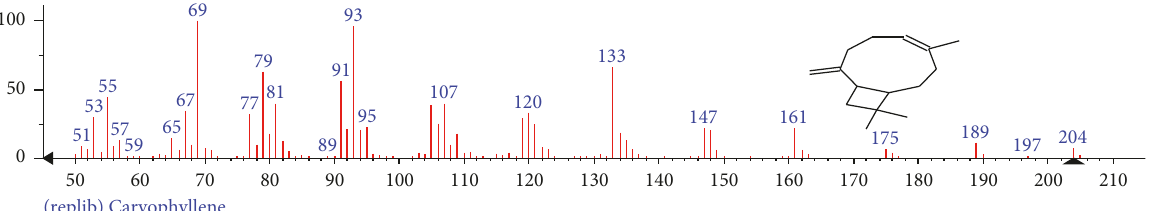
Figure 21: Mass spectrum of compound caryophyllene of whole plant hexane fraction of Achillea wilhelmsii (WHFAW).